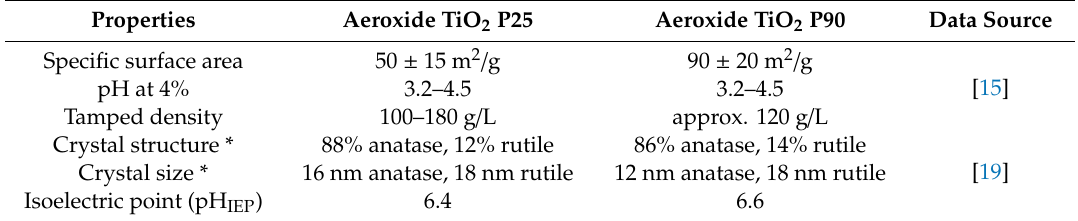
Figure 8. Schematic drawing of the photocatalytic reactor. Table 4. Characteristics of photocatalysts P25 and P90.